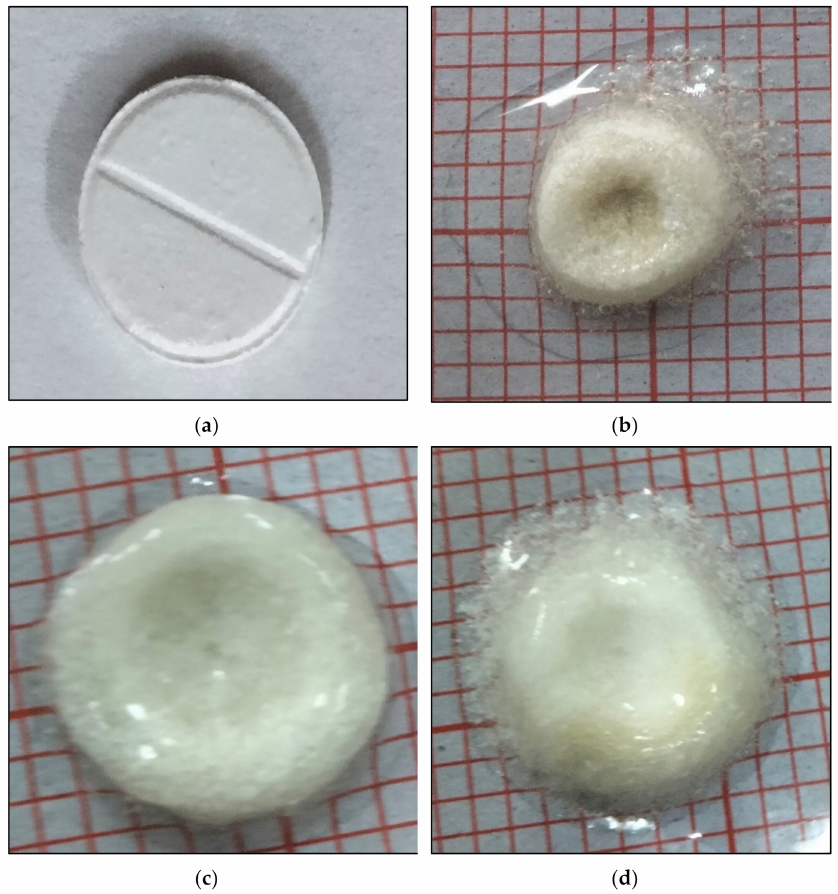
Figure 4. Swelling behavior of effervescent floating tablet of metronidazole (F3) ( a ) tablet at 0 h, ( b ) tablet swelling after 2 h, ( c ) tablet swelling after 4 h ( d ) tablet swelling after 8 h. All the formulations were incorporated with NaHCO 3 as gas generating agent. The tablets afloat and remained buoyant for hours. The total lag time as well as total floating duration for all the optimized formulations are presented in Table 6. It was noted that F4